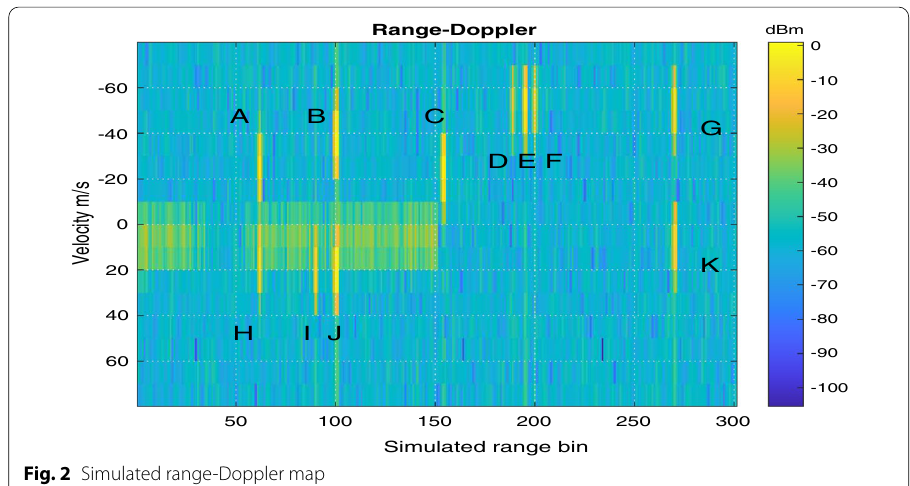
Fig. 2 Simulated range-Doppler